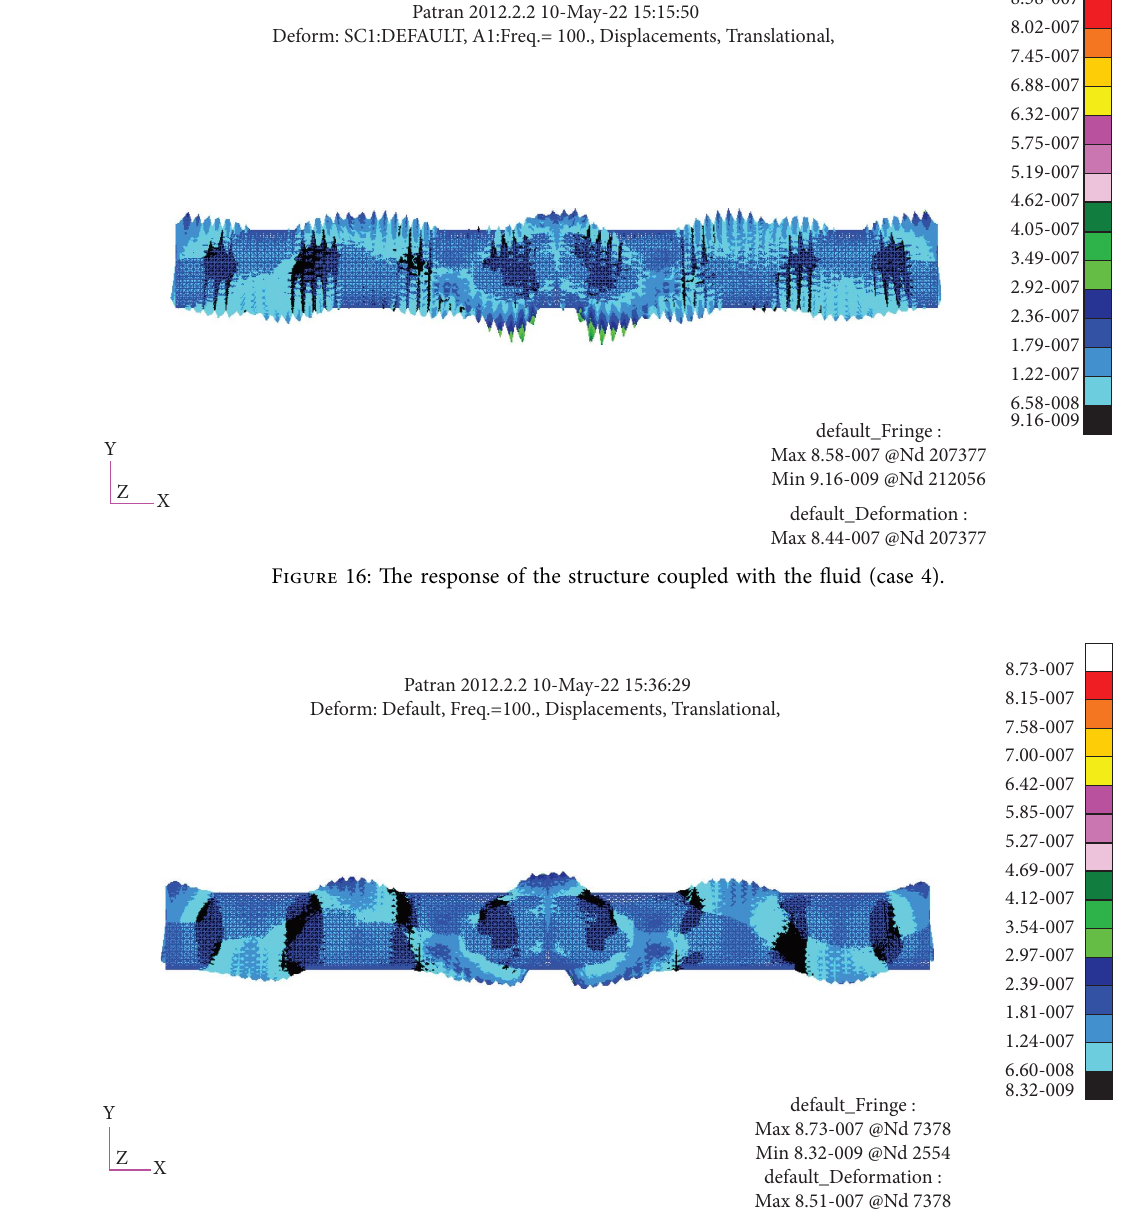
Figure 17: Te response of the structure coupled with the fuid (case 3). Table 3: Computational